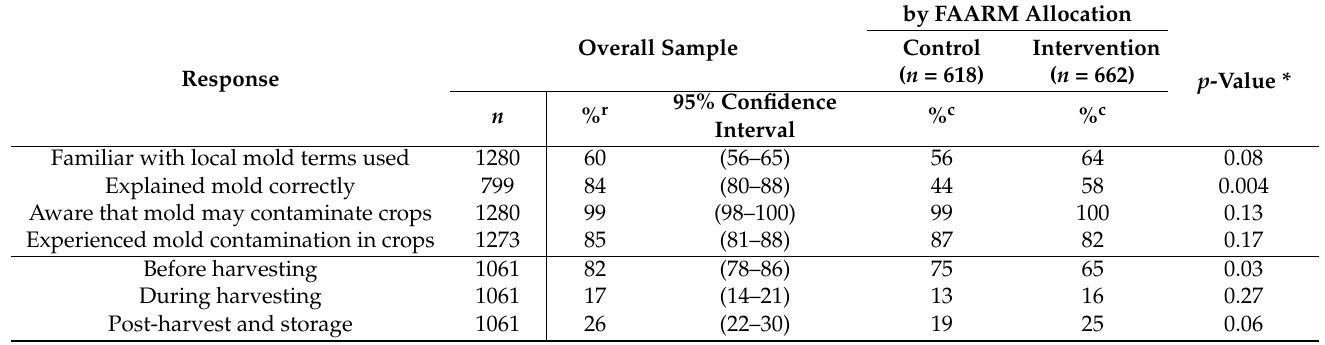
Table 3. Level of awareness, understanding, and experience with mold